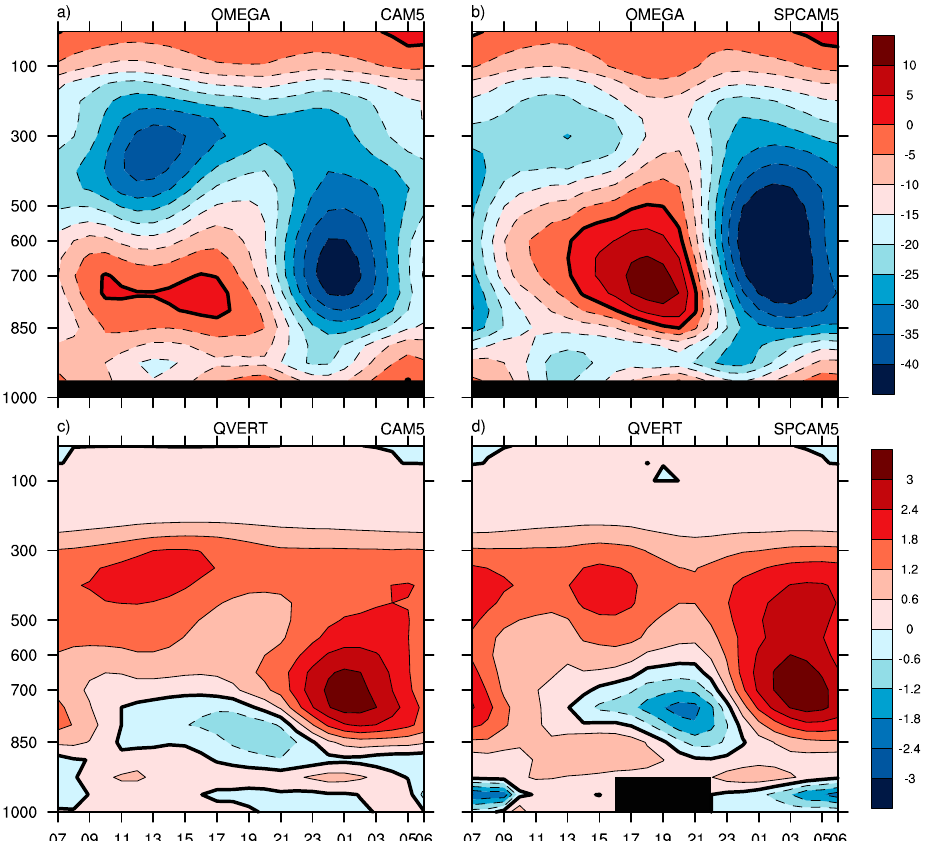
Figure 6. The hour–pressure transects (eastern plain) of the pressure vertical speed (hPa · day − 1 ) in ( a ) CAM5 and ( b ) SPCAM5; the vertical moisture advection tendency (scaled to K · day − 1 ) in ( c ) CAM5 and ( d ) SPCAM5.